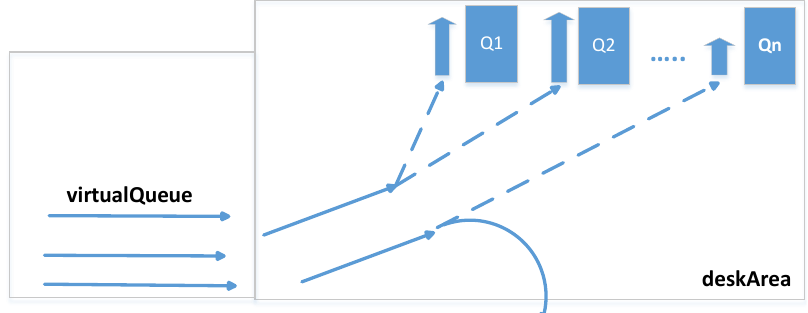
Figure 7. From virtual queue to desk area, or separating clients to